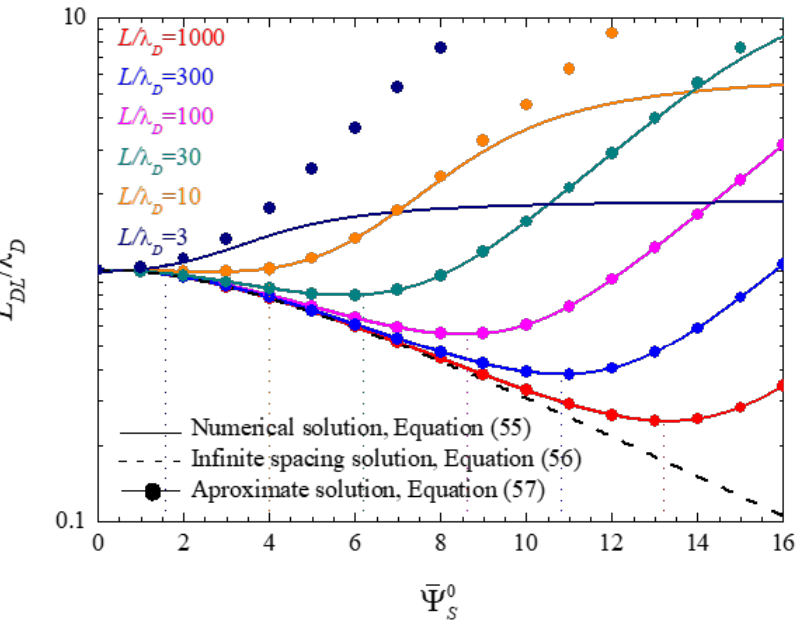
Figure 3. Dependence of the electric double layer thickness values on the surface potential, calculated for the indicated L / λ D values. Vertical dot lines show surface potential values corresponding to the double layer thickness minima, Equation (58).